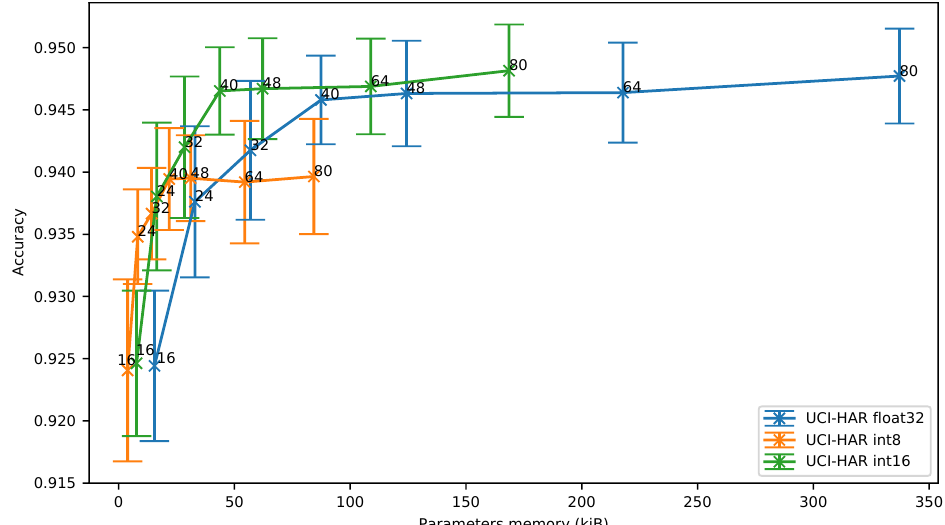
Figure 5. Human Activity Recognition dataset (UCI-HAR): accuracy vs. filters.